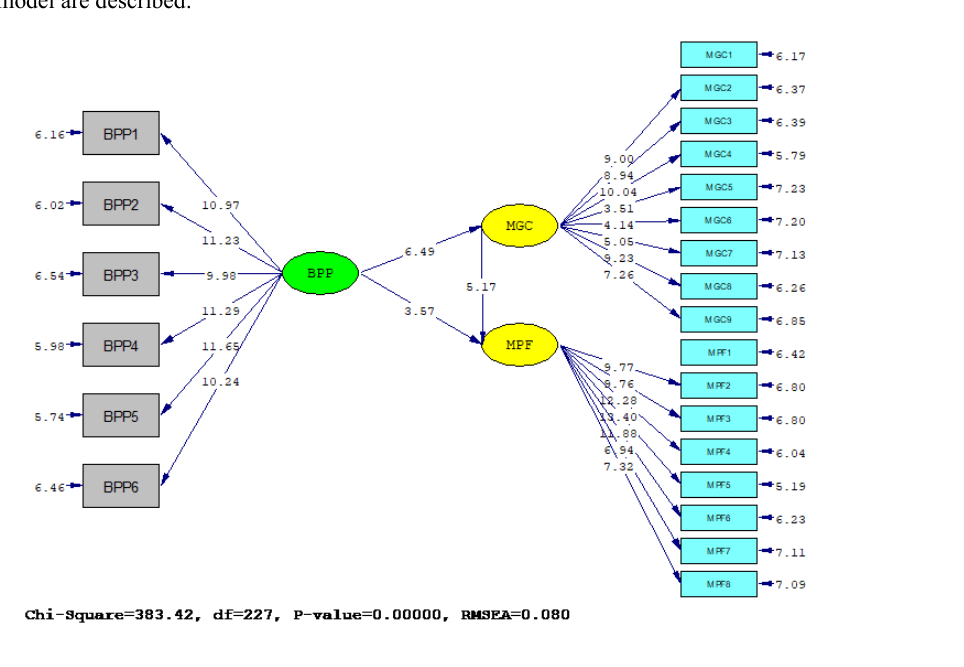
Fig. 2. Comprehensive Solution Structural Model Diagram Source: Processed Data